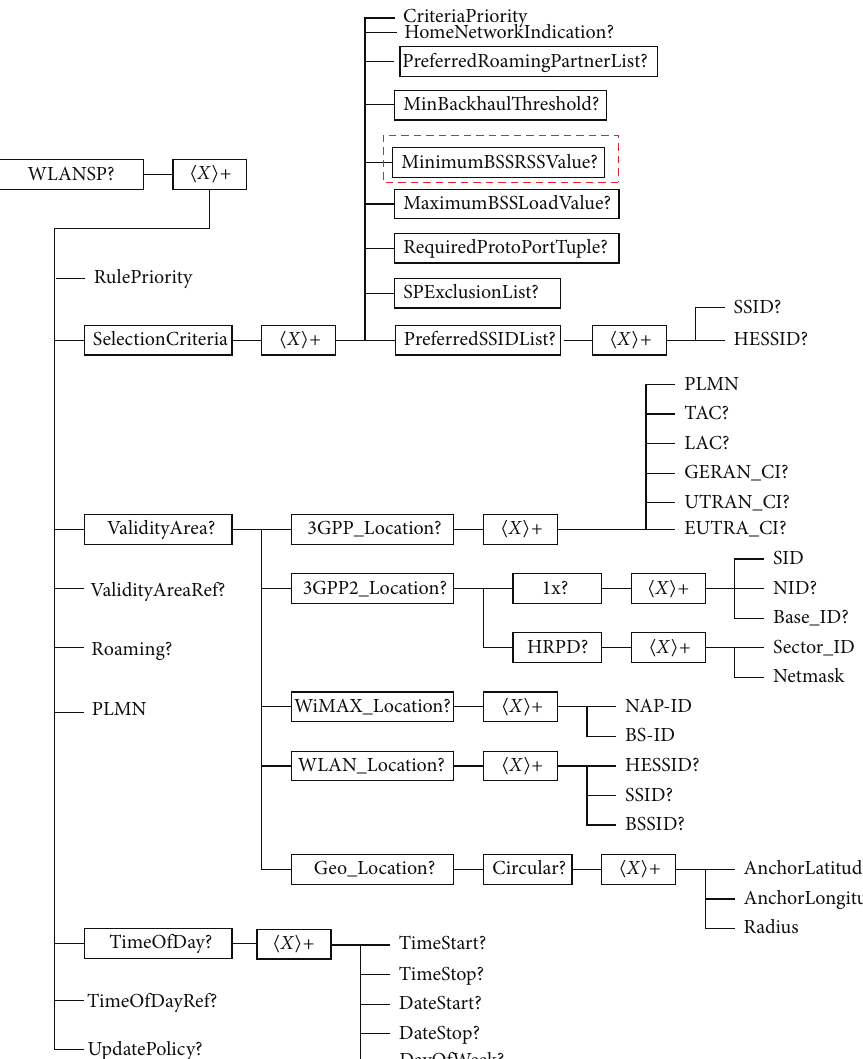
Figure 2: Example of enhanced ANDSF OM for